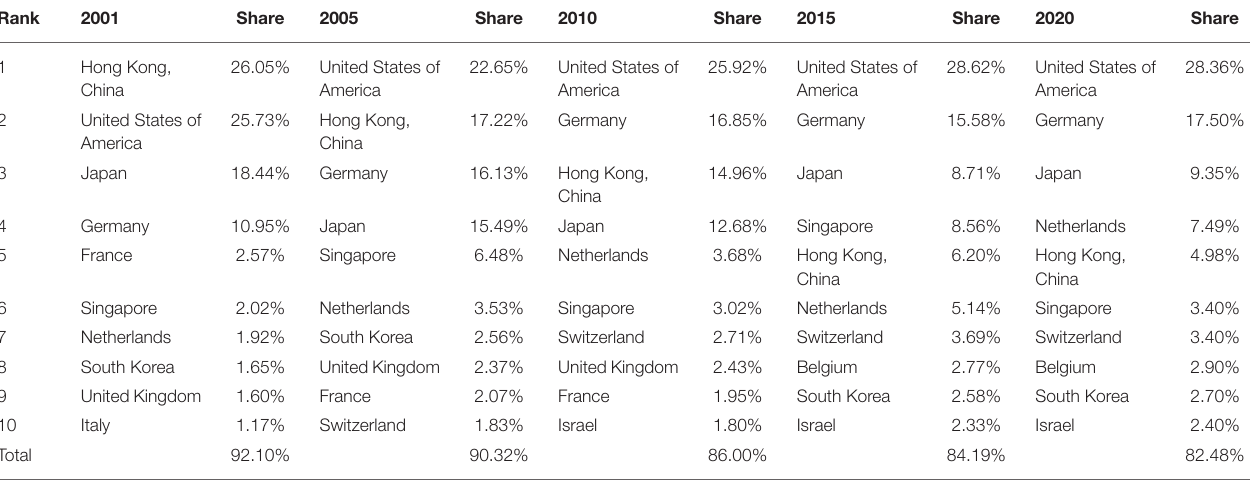
TABLE 6 | Changes in China’s major import markets for medical devices and their shares. Rank